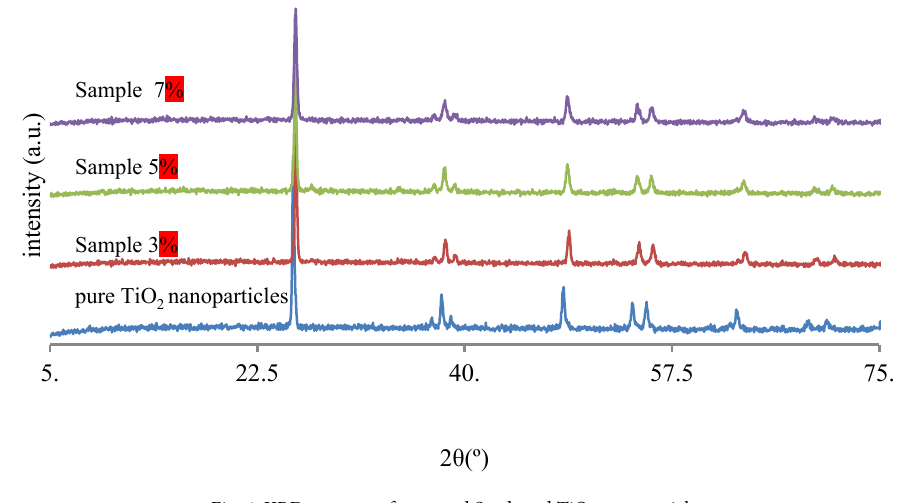
Fig. 4. XRD patterns of pure and Sn-doped TiO